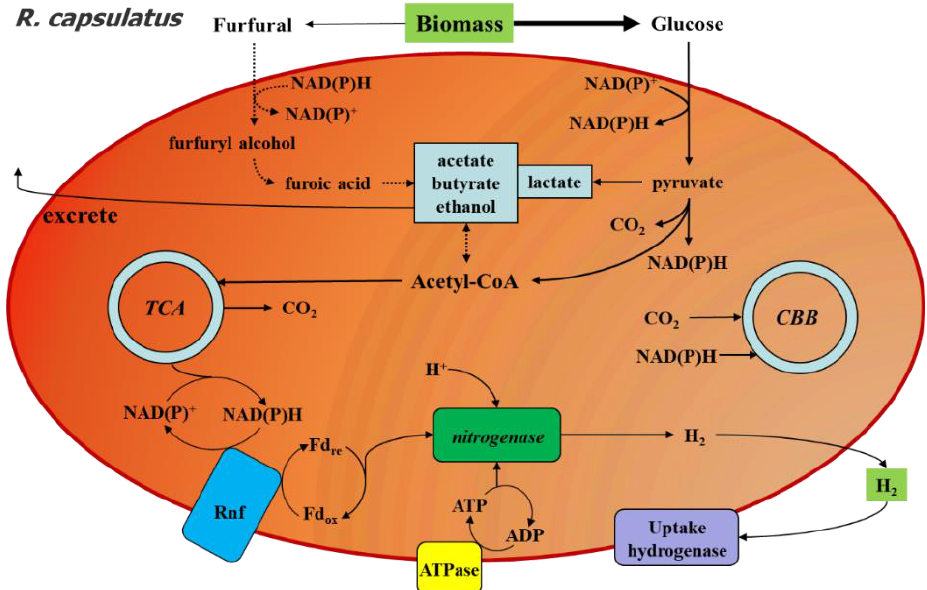
Figure 7. Proposed metabolic responses of Rhodobacter capsulatus to furfural in hydrogen production. Putative metabolism of furfural into cells is represented by dotted lines, the diagram of photosynthesis is omitted.